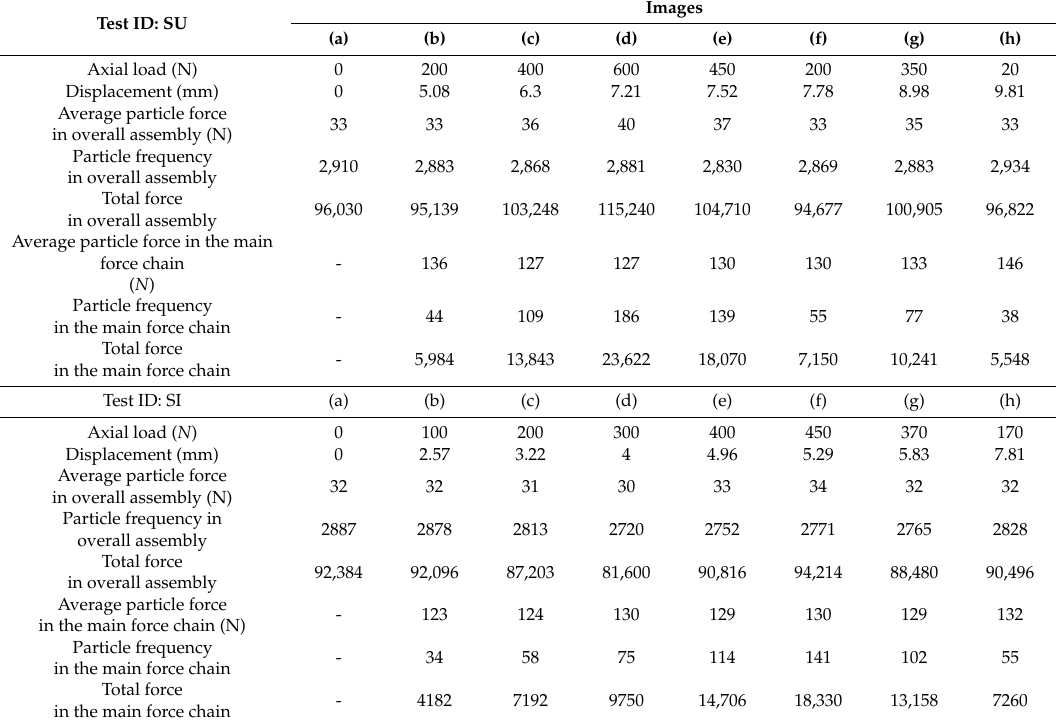
Table 2. Summary of quantitative detection of granular assemblies under shallow